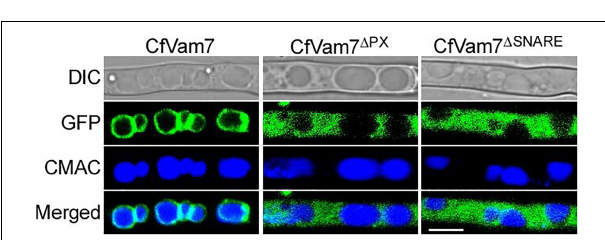
FIGURE 8 | The Phox homology (PX) and SNARE domain contributes to the vacuolar membrane localization of CfVam7. Hyphae of GFP-CfVam7 strain were incubated on liquid medium for 24 h. 7-Amino-4-chloromethylcoumarin (CMAC) staining of vacuole was performed at the 37 ◦ C for 30 min. Photographs were examined under differential interference contrast (DIC) or epifluorescence microscopy. The merged panels showed the CfVam7 localizes to vacuolar membrane in (cid:49) Cfvam7 / CfVAM7 , and the subcellular localization of GFP-CfVam7 (cid:49) SNARE and GFP-CfVam7 (cid:49) PX proteins changed. Bar = 10 µ